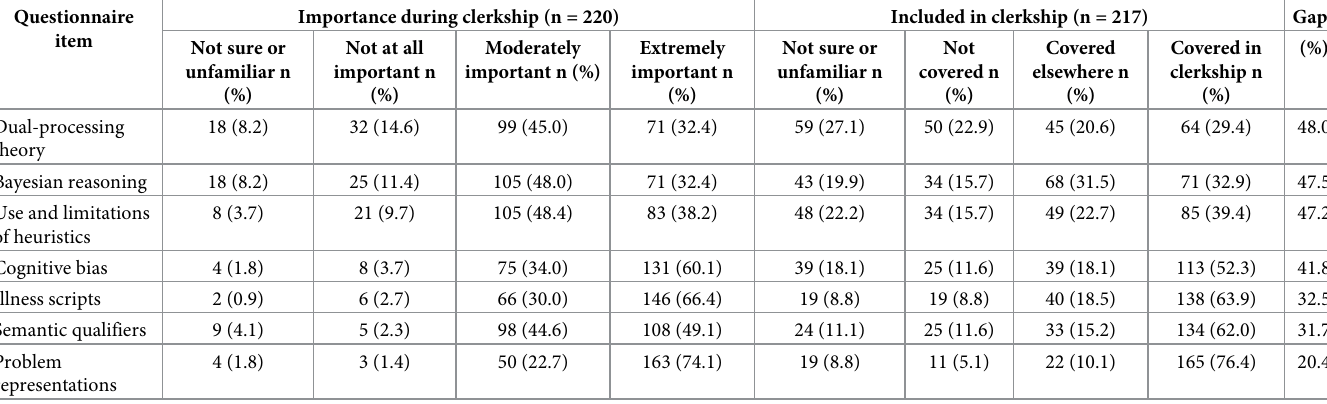
Table 3. Importance of teaching clinical reasoning concepts during the clerkship and degree to which they are included in clerkship phases (clerkship leaders) a . Questionnaire item